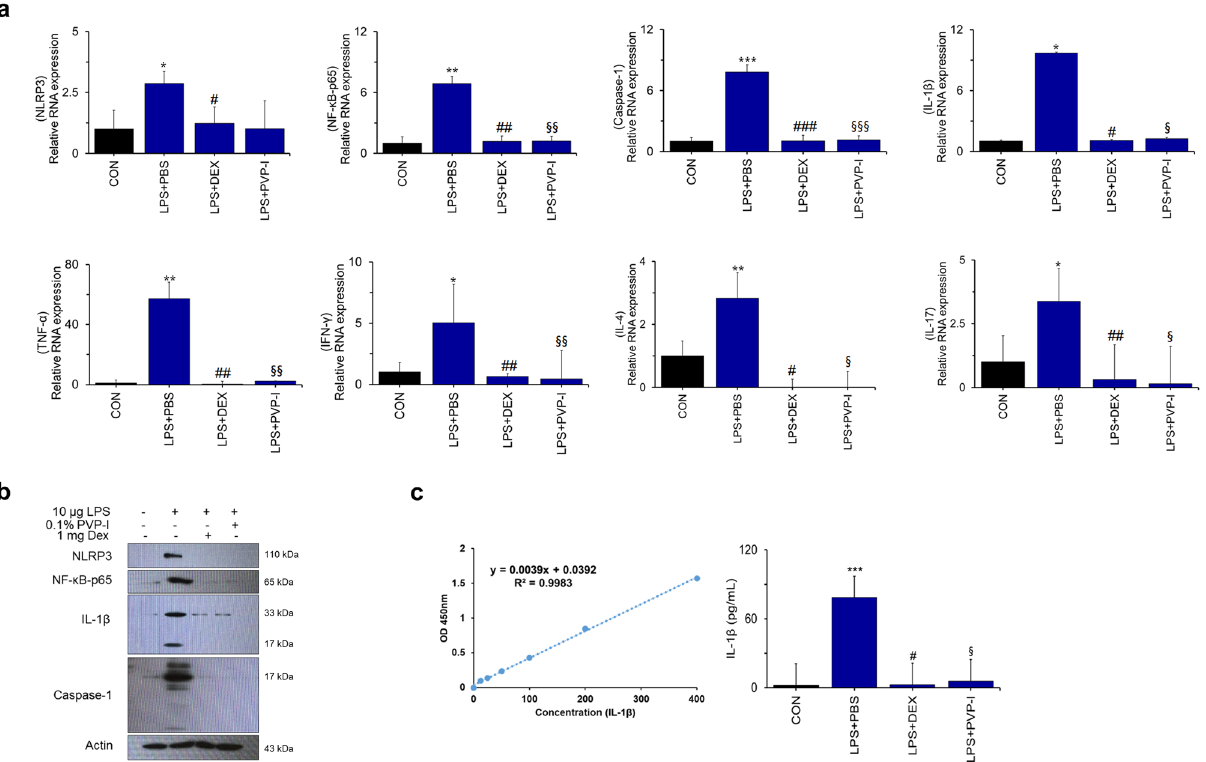
Figure 7. PVP-I inhibits TLR4 and MyD88 complex formation in nasal polyps mouse model. ( a ) Bar graphs represent the relative expression of cytokines. Statistical significance: * P < 0.05, ** P < 0.01 and *** P < 0.001 compared with the control group; # P < 0.05, ## P < 0.01 and ### P < 0.001 compared with the LPS + PBS group; § P < 0.05, §§ P < 0.01 and §§§ P < 0.001 compared with the LPS + DEX group. ( b ) The expression of NLRP3, NF-κB-p65, caspase-1 and IL-1β were measured using an immunoblot in murine nasal mucosa tissues. Actin protein was used as a loading control. ( c ) Production of IL-1β in the nasal lavage fluid (NLF) were measured using the ELISA assay. Statistical significance: *** P < 0.001 compared with the control group; # P < 0.05 compared with the LPS + PBS group; § P < 0.05 compared with the LPS + DEX